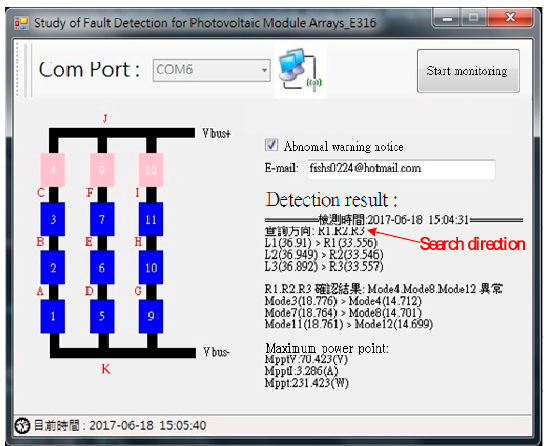
Figure 7. Interface of fault diagnosis software.